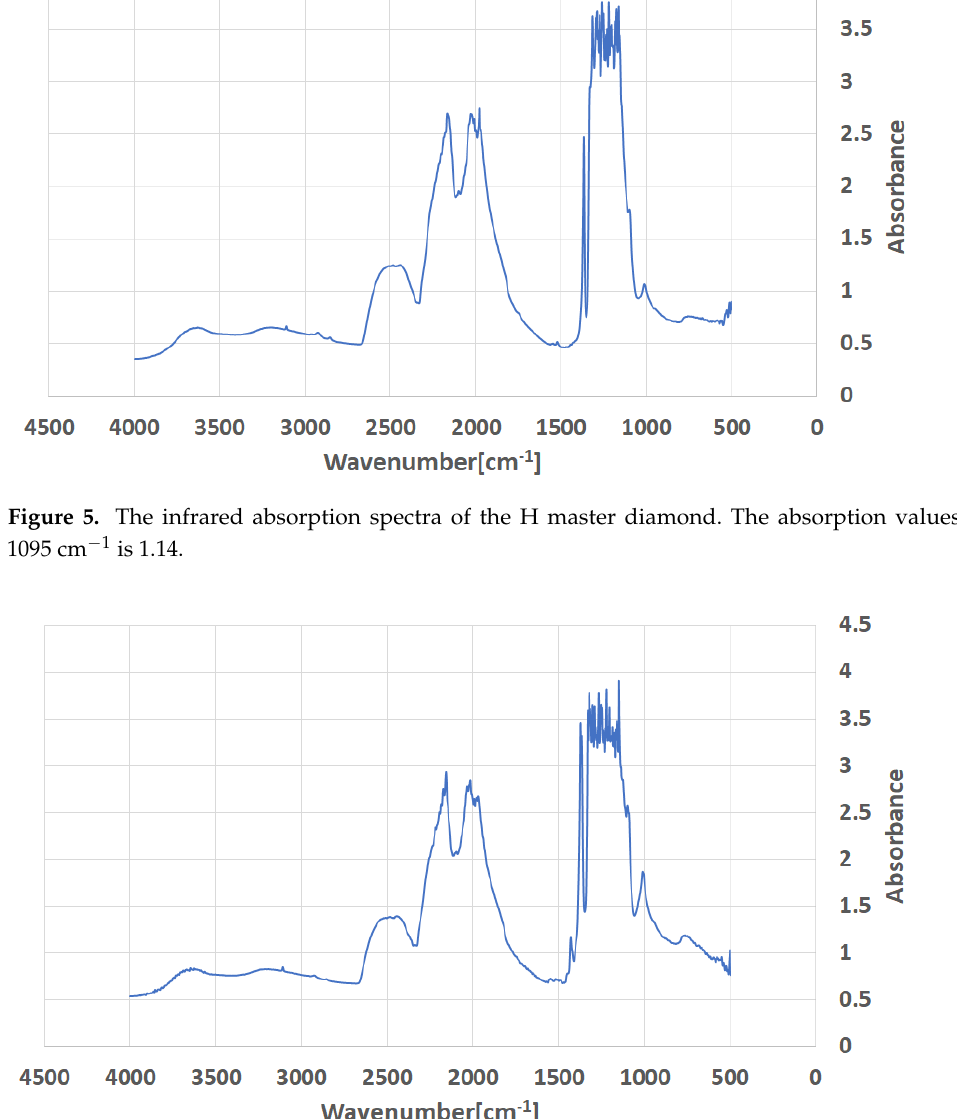
Figure 6. The infrared absorption spectra of the L1 master diamond. The absorption values at 1095 cm − 1 is 1.84.